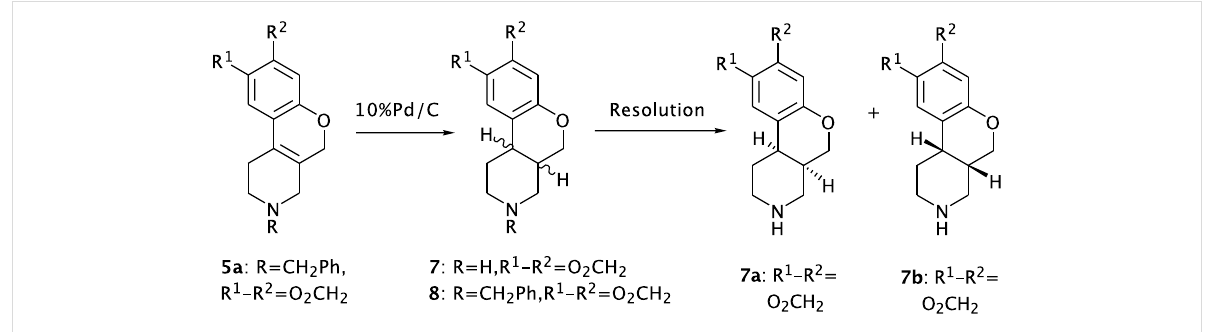
Scheme 1: Synthetic sequence to tetrahydropyridine compounds.